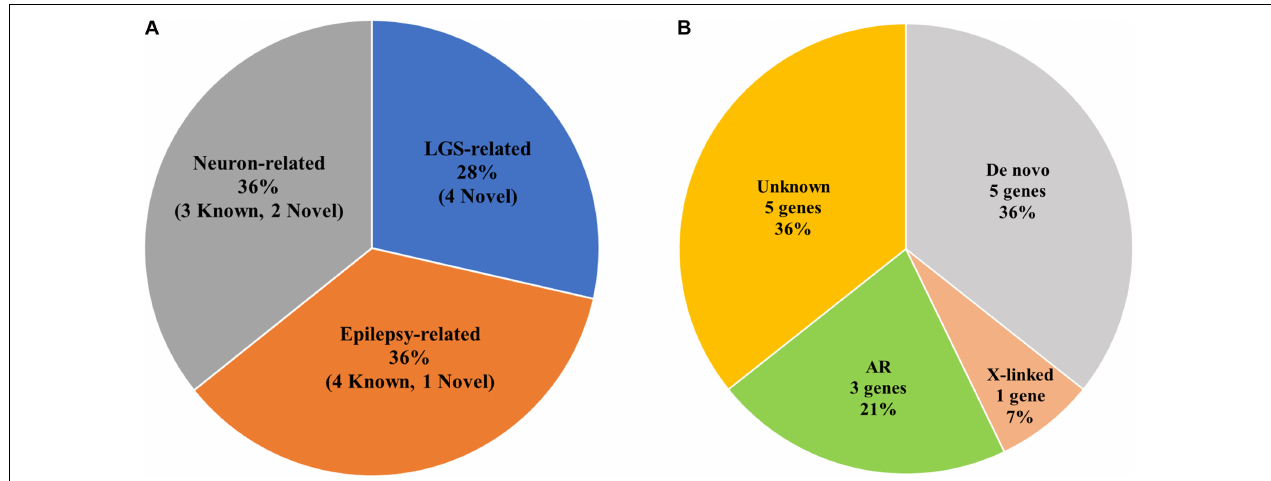
FIGURE 3 | Statistics of genetic variations in candidate genes of LGS or LGS-like epilepsy. (A) Pie chart of the frequency of LGS, epilepsy, or neuron-related genes. () indicates the number of genetic variations in candidate genes. (B) Ratio of Mendelian inheritance patterns of candidate genes.